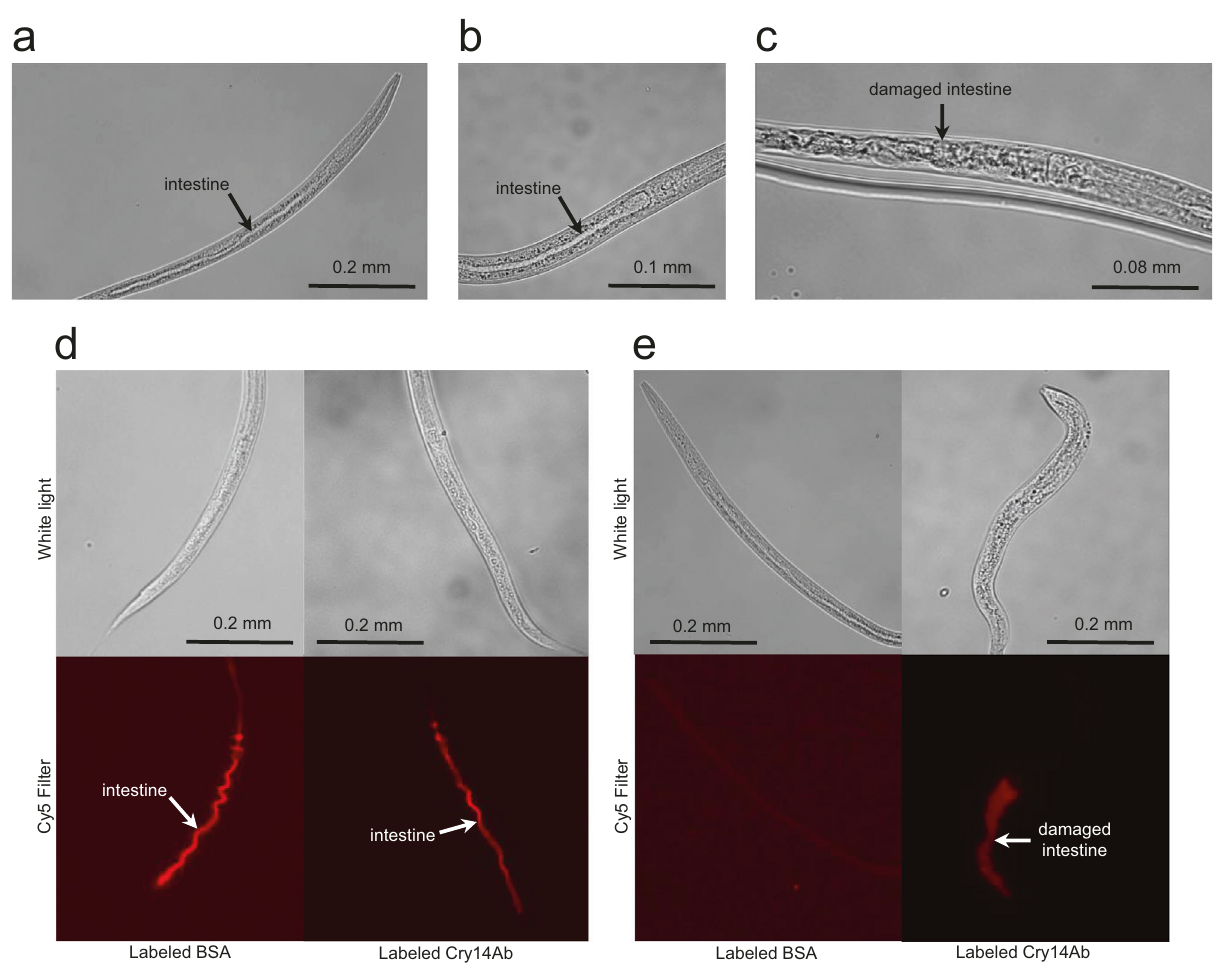
Fig. 6 Bovine serum albumin and Cry14Ab were fl uorescently labeled and fed to C. elegans to observe the effects on the intestine. The experiment was performed twice. Under each condition 50 nematodes were observed, 3 were photographed, and 1 is shown here. a Negative control, with no fed protein, after incubation for 24 h; b labeled BSA fed for 24 h; c labeled Cry14Ab fed for 24 h, showing damage to the intestine. d To demonstrate that labeled protein was being ingested, worms were fed labeled protein for 4 h, washed to remove excess labeled protein, and imaged under white light or with a Cy5 fi lter set. e To determine if Cry14Ab remained associated with the intestine, worms were fed labeled protein for 24 h, washed to removed excess labeled protein, and incubated without labeled protein for another 24 h before being imaged under white light or with a Cy5 fi lter set. Source data are provided as a Source Data fi